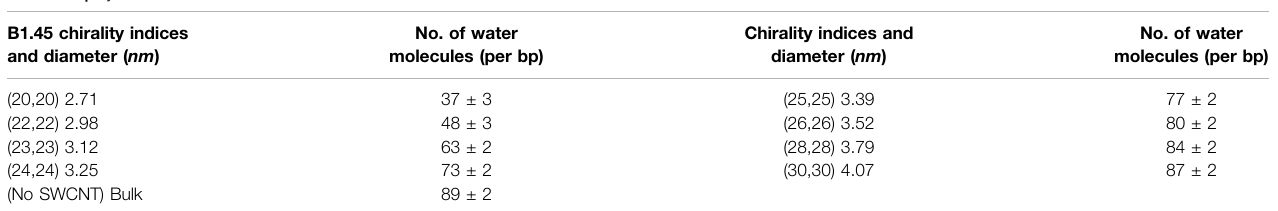
TABLE 2 | Hydration status of dsDNA inside SWCNTs of different